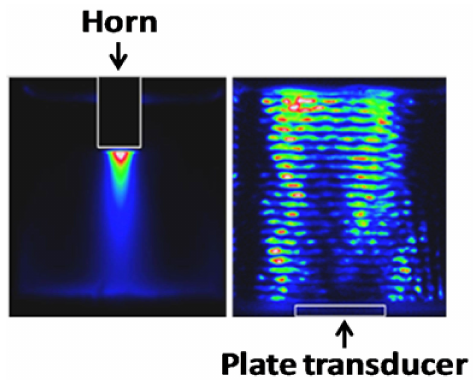
Figure 1. Spatial distribution of cavitation bubbles generated by an ultrasonic horn ( left ) and 168 kHz frequency plate transducer ( right ). Image adapted from [32] with permission from © Springer Science + Business Media Singapore 2018 and the colours were arbitrarily added to indicate the sonoluminescence emission